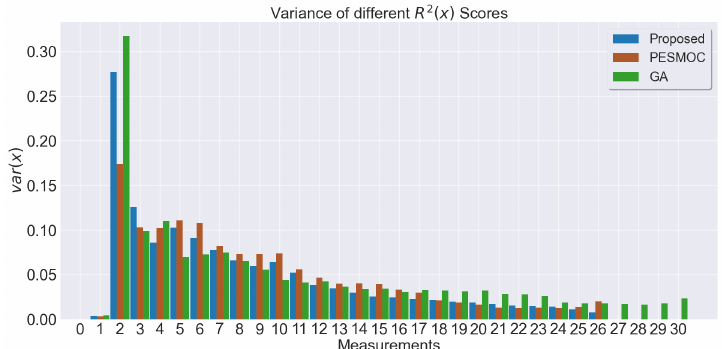
Figure 10. Average variance of R2Ss of multiple surrogate models using different methods. The more the method generalizes the acquisition, the lower the variance.